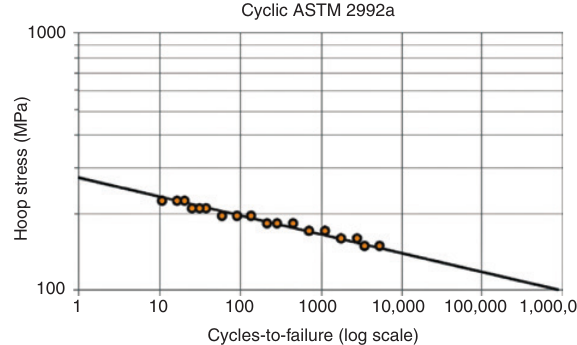
Figure 1: Regression analysis according to ISO 14692 and ASTM D2992 [1, 2].